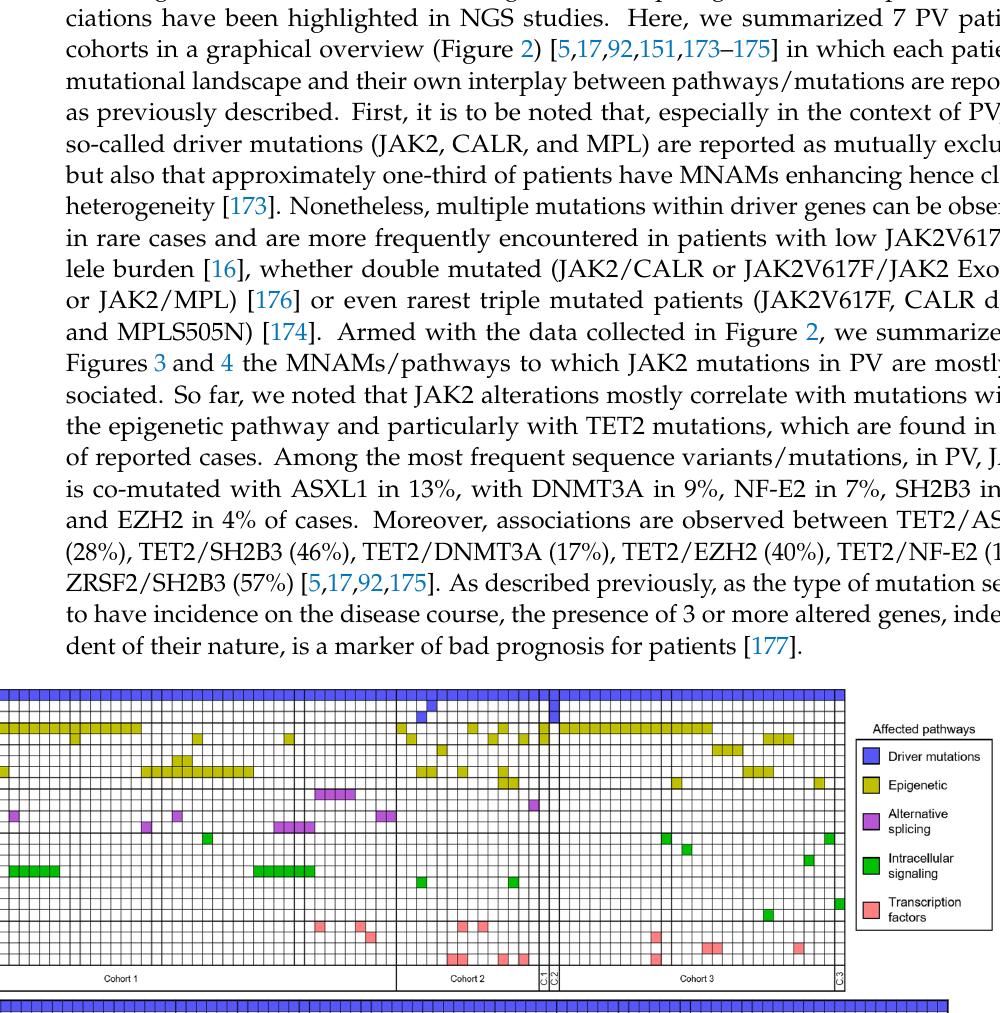
Figure 3. Overview of JAK2/MNAMs association in PV (total = 268 combinations) (based on Figure 2 related data). A visual dot plot representation of JAK2 associated mutations grouped by pathway ( A ) and individual affected gene ( B ) (each circle represents 1% of the total). Abbreviation: Alt. Splic ‐ ing = Alternative Splicing; Intra. signaling = Intracellular signaling; Trans. factor = Transcription factor.